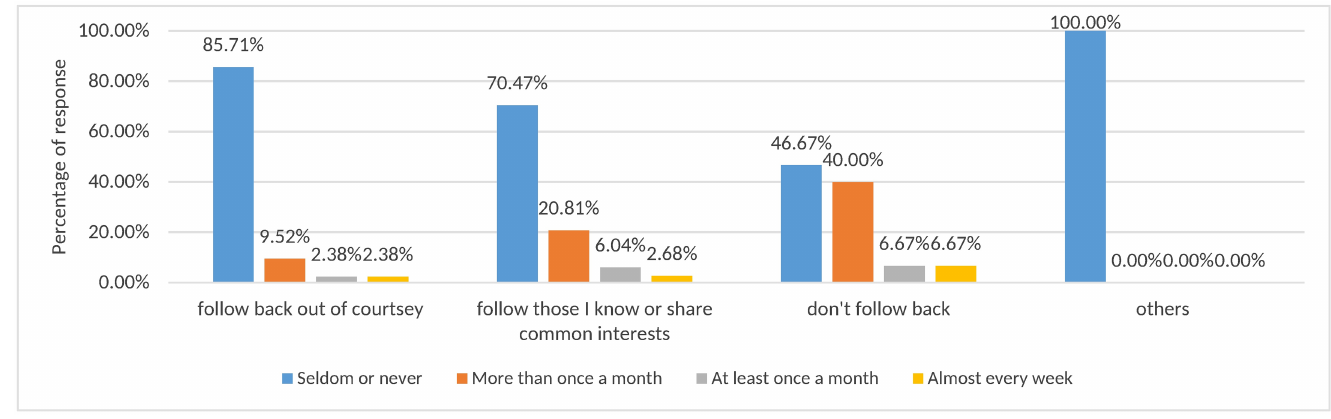
Fig 2. Users’habits about following and cleaning up friends.